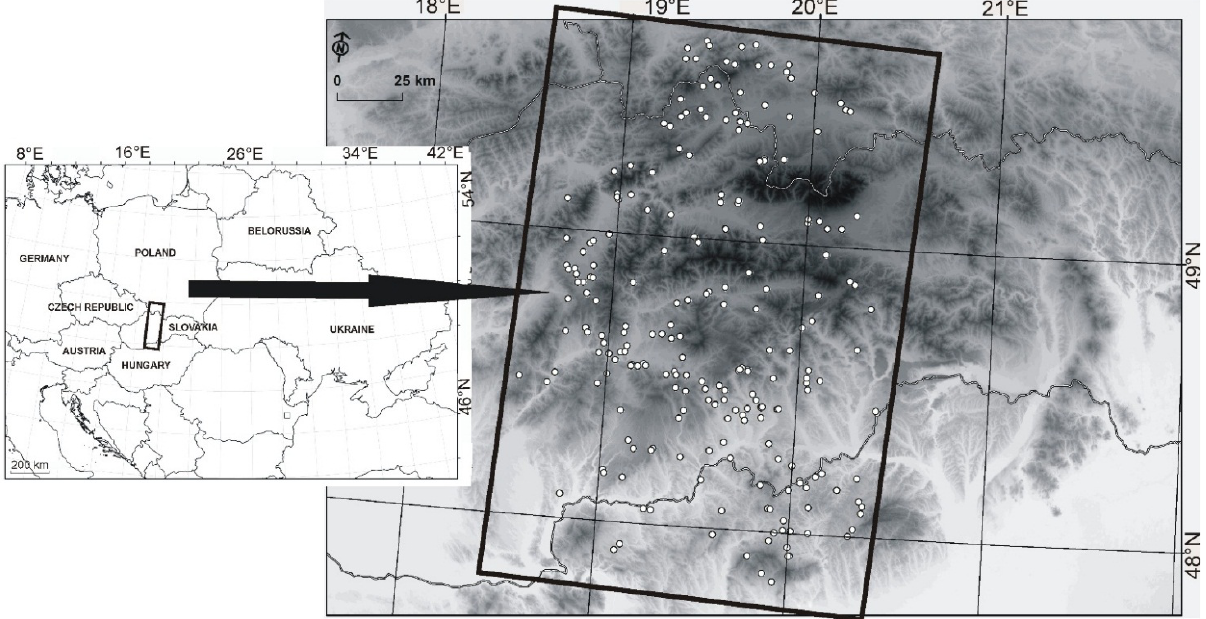
Figure 1. Study area and distribution of vegetation